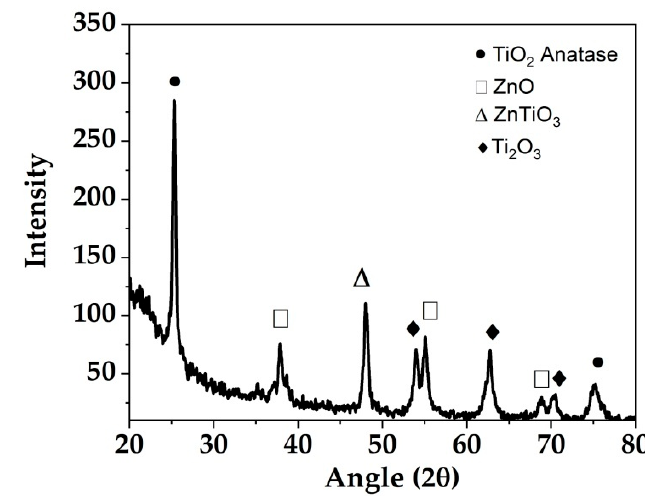
Figure 8. X-ray di ff raction (XRD) pattern of TiO 2 / ZnO Figure 8. X-ray diffraction (XRD) pattern of TiO 2 /ZnO nanofibers. Figure 8. X-ray diffraction (XRD) pattern of TiO 2 /ZnO nanofibers.